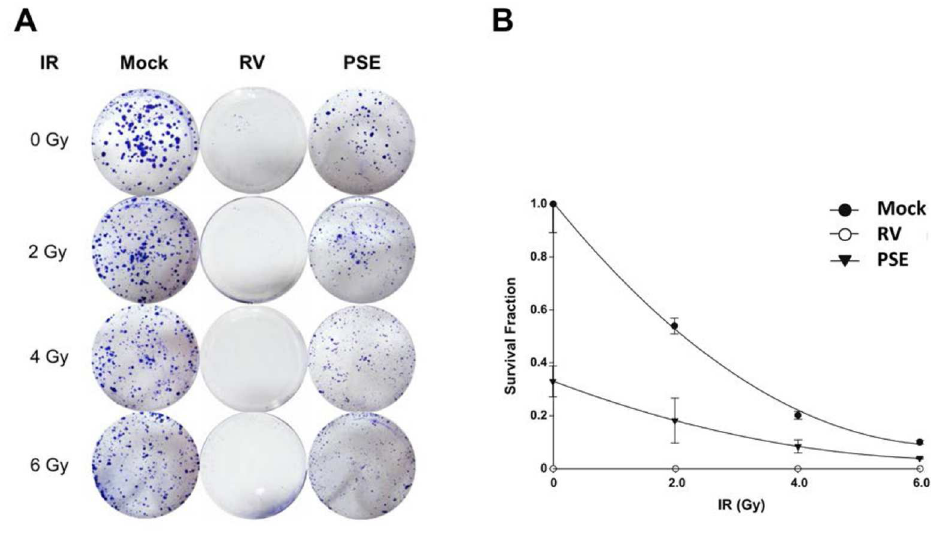
Fig 3. Resveratrol (RV) and peanut stem extract(PSE) increaseradiosensitivity of prostate cancer cells. LAPC4-KDcells were treated with irradiation(IR, 0–6 Gy) alone or combinedwith RV or PSE (25 or 500 μ g/mL, respectively). After 10-day incubation, survival cell colonieswere (A) stained with crystal violet and (B) assessed using clonogenicassays as describedin the